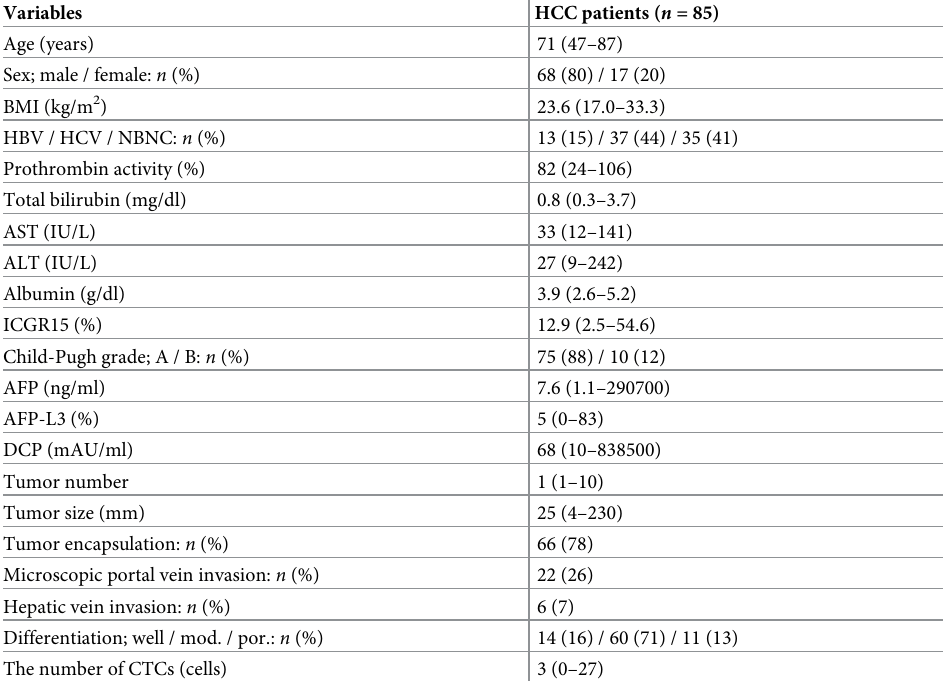
Table 1. Clinicopathologic